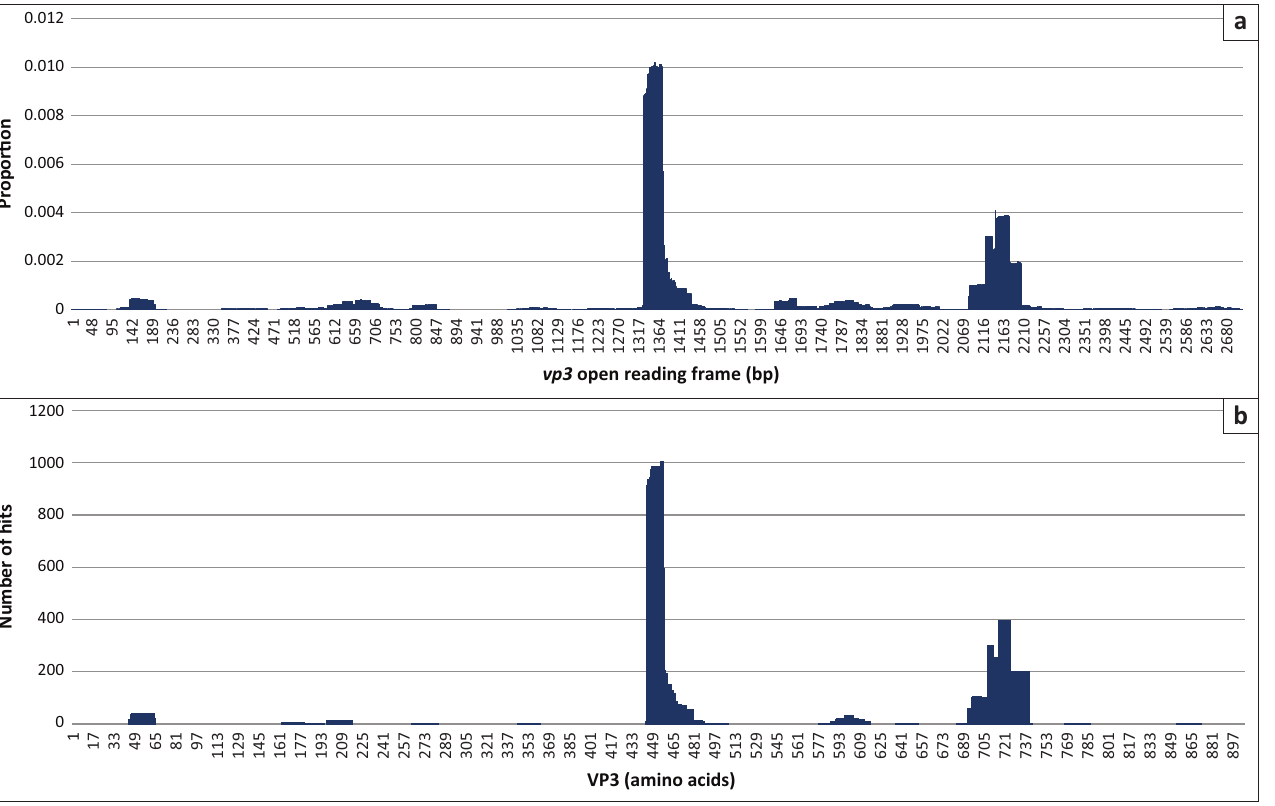
FIGURE 6: A comparison of the pattern of nucleic sequences mapping to the gene and the deduced amino acid alignments of the selected peptides using the day 28 VP3 data of Horse 2 as an example. (a) Nucleic acid mapping and (b) amino acid